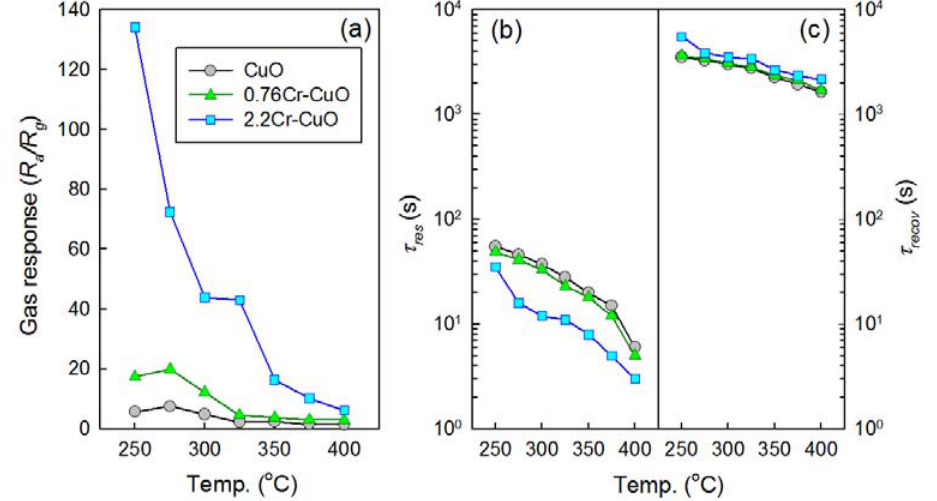
), and ( c ) 90% recovery res over the range 2